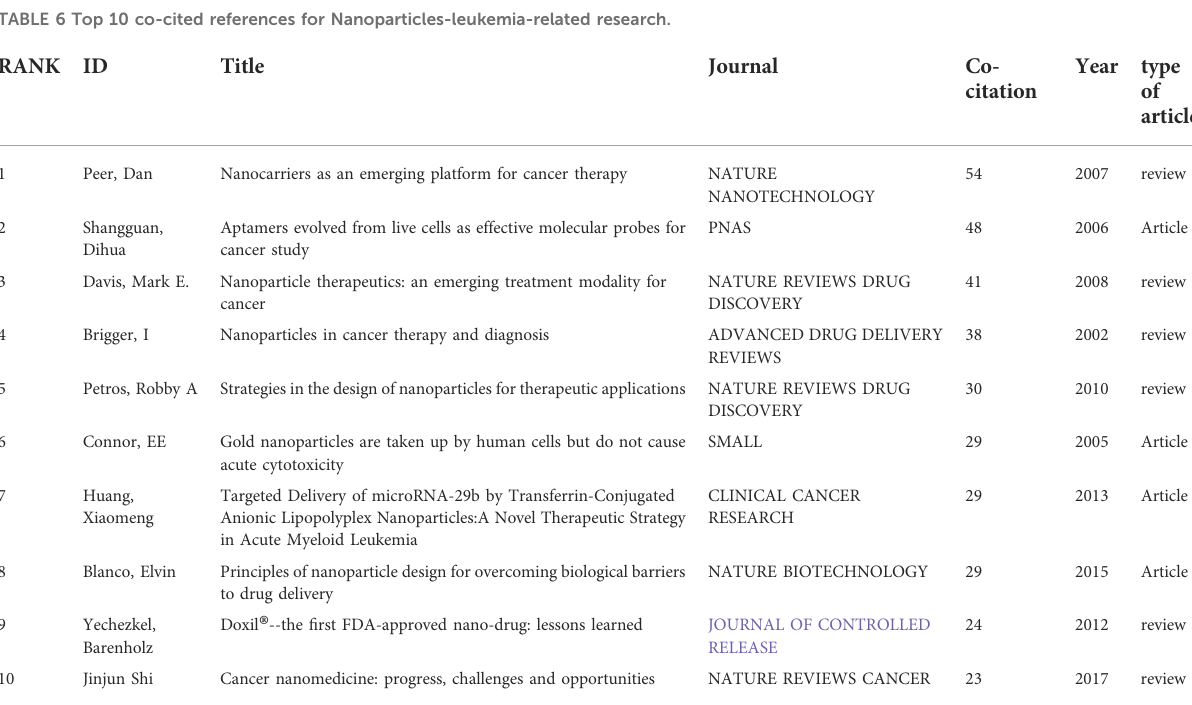
Year type citation